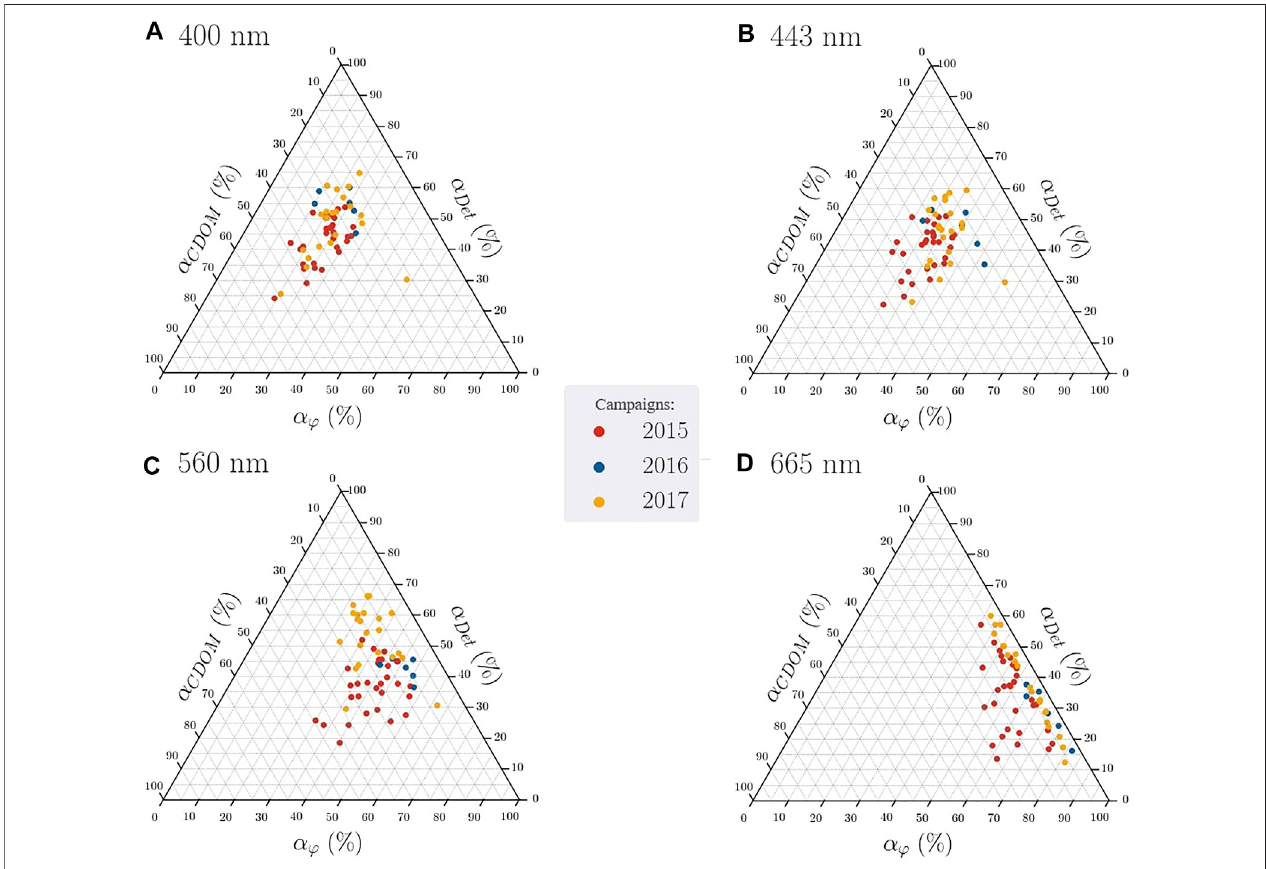
FIGURE 5 | Phytoplankton, CDOM, and detritus absorptions at OLCI bands (A) Oa01, (B) Oa03, (C) Oa06, and (D) Oa08. Note that campaigns 2015, 2016, and 2017 refer to Jul/2015, July/2016, and Aug/2017, respectively. The α nw was calculated based on the sum of laboratory-measured IOPs ( α nw = α CDOM + α phy + α det ).